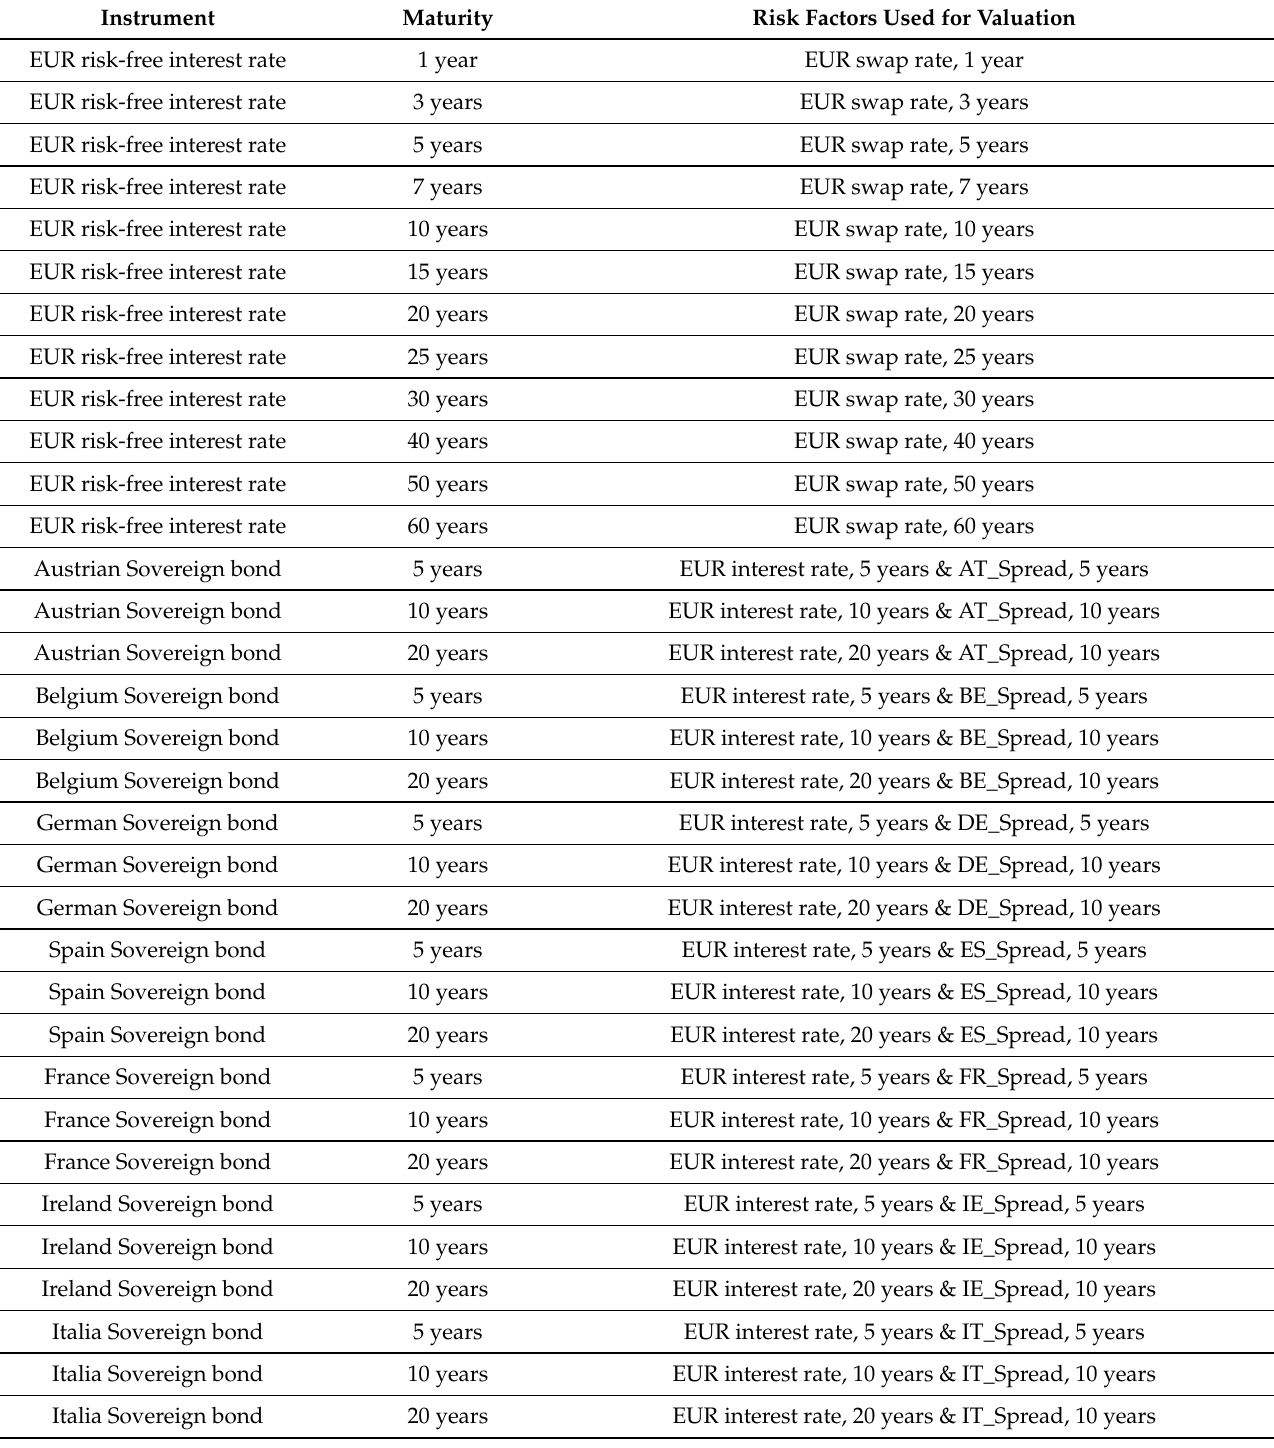
Table A2. Mapping of instruments to risk factors used in GAN-based internal